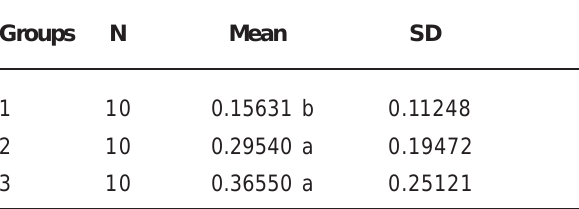
TABLE 1- Mean and standard deviation (SD) values of the difference between the first and second working length measurements (mm). The statistical groupings are also shown at the mean values column. Different letters indicate statistically significant difference